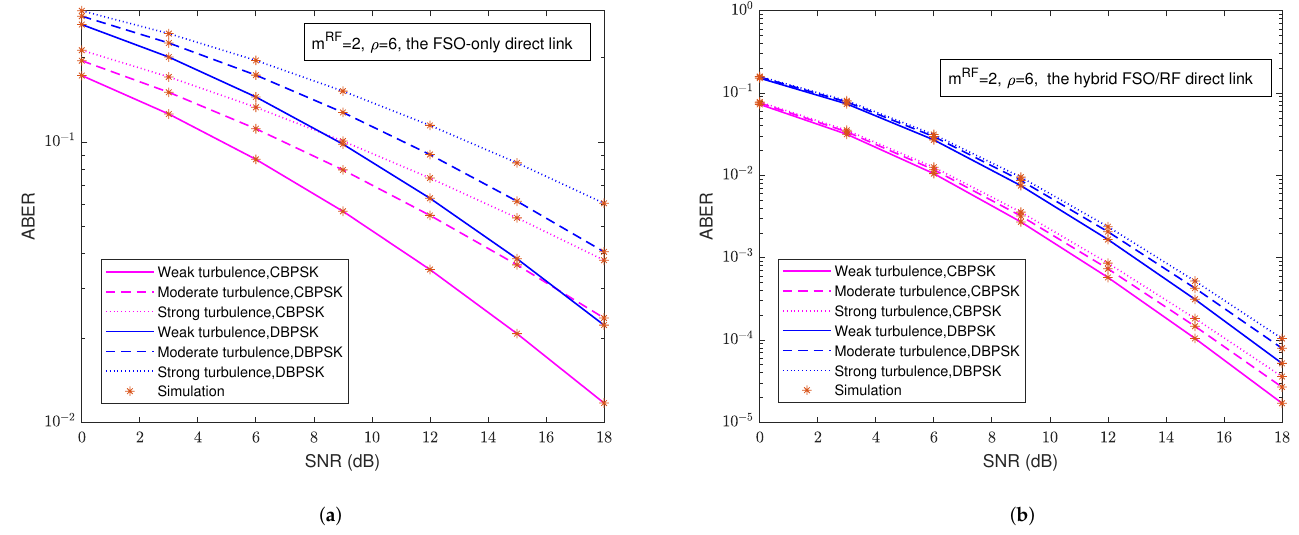
Figure 2. Influence of different modulation schemes and turbulence intensity on ABER performance of direct link. ( a ) The FSO-only direct link. ( b ) The hybrid FSO/RF direct